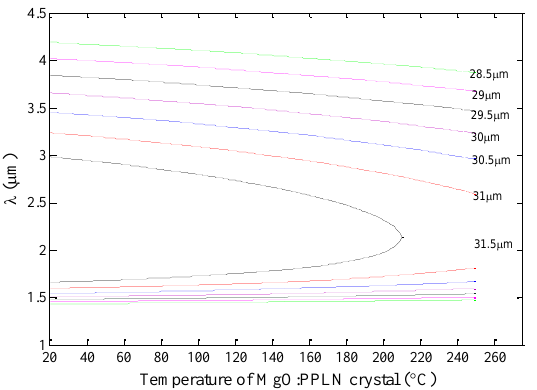
Figure 6. Theoretical tuning curves for eight periods of the MgO:PPLN crystal.